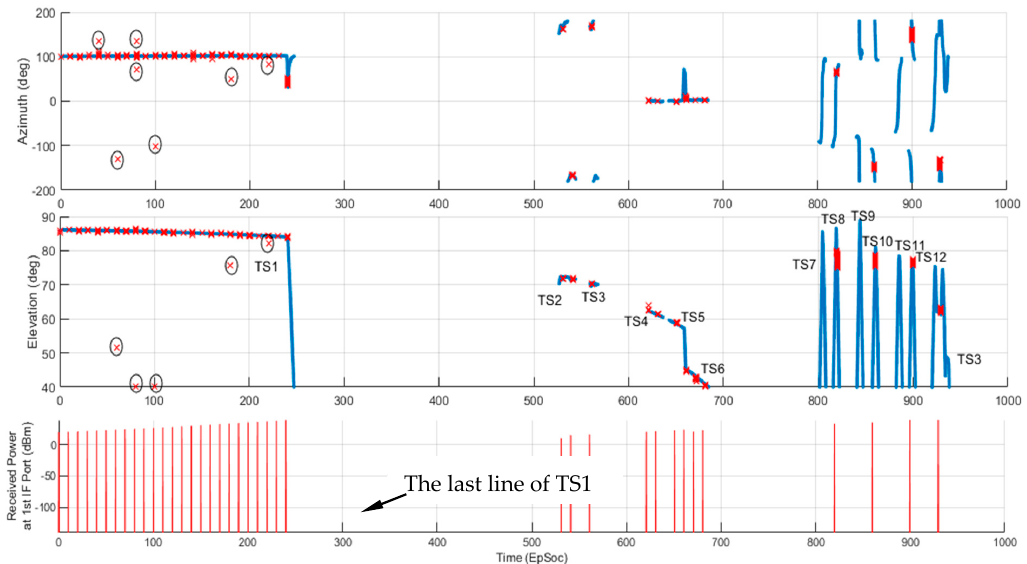
Figure 13. CS—based AoA estimated Az and El (red ‘x’) vs. STK data (blue lines). The details around the last line (in the bottom plot) of the TS1 are given in Figure 15.